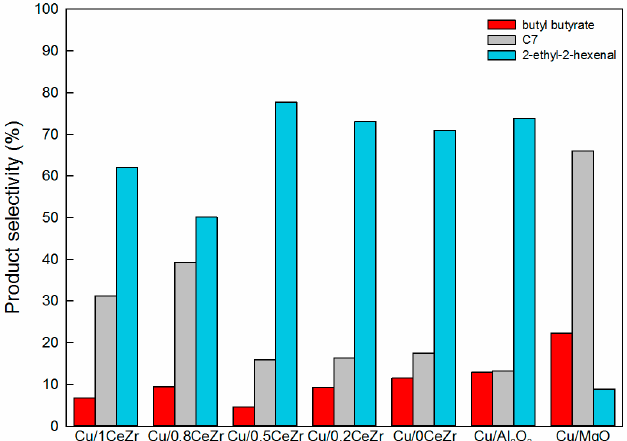
Figure 8. Product selectivities obtained in the reaction of acetone with butyraldehyde over Cu/ x CeZr, Cu/Al 2 O 3 , and Cu/MgO catalysts. Cu/Al 2 O 3 , and Cu/MgO